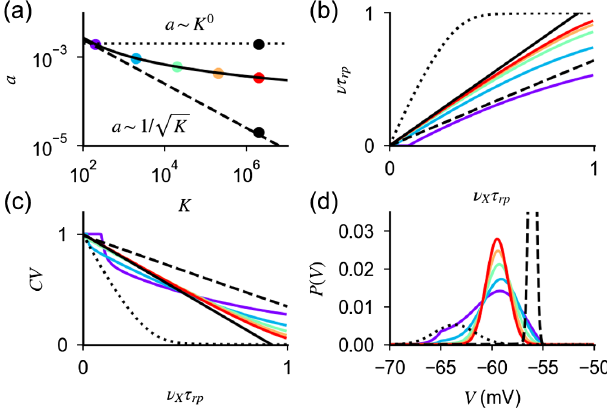
FIG. 3. Response of networks of conductance-based neurons for large K . (a) Scaling relation defined by self-consistency condition given by Eqs. (14) and (19) (black line), values of parameters used in (b) – (d) (colored dots). Constant scaling ( a ∼ K 0 , dotted line) and scaling of the balanced state model ffiffiffiffi p K ( a ∼ 1 = , dashed line) are shown for comparison. (b),(c) Firing rate and CV of ISI as a function of the external input, obtained from Eqs. (10) and (15) (colored lines) with the strong-coupling limit solution of Eqs. (20) and (16) (black line). (d) Probability distribution of the membrane potential obtained from Eq, (17). In (b) – (d), dotted and dashed lines represent quantities obtained ffiffiffiffi p K with the scalings J ∼ K 0 and J ∼ 1 = , respectively, for values of K and J indicated in (a) (black dots). Parameters: γ ¼ 1 = 4 and g ¼ 30